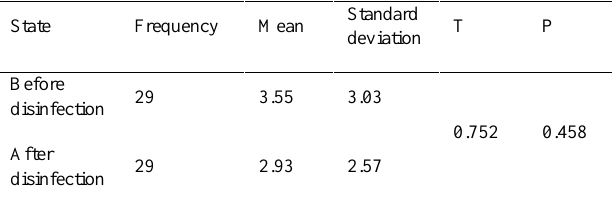
Table 1. Bacterial diversity before and after disinfection in A hospital (T-test)